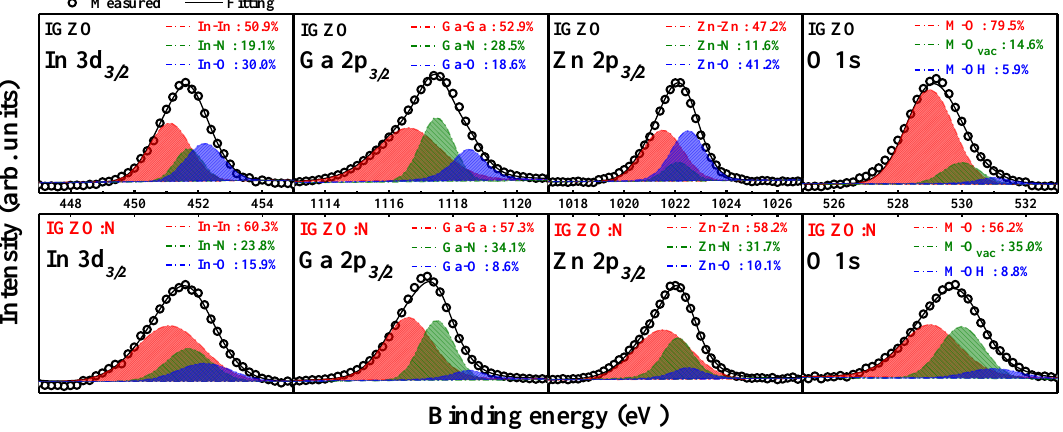
Figure 3. XPS spectra of In 3d 3/2 , Ga 2p 3/2 , Zn 2p 3/2 , and O 1s peaks in IGZO and IGZO:N nanocomposites. Table 1. XPS binding energy values and atomic concentrations for each metal species in IGZO and IGZO:N nanocompo- sites.